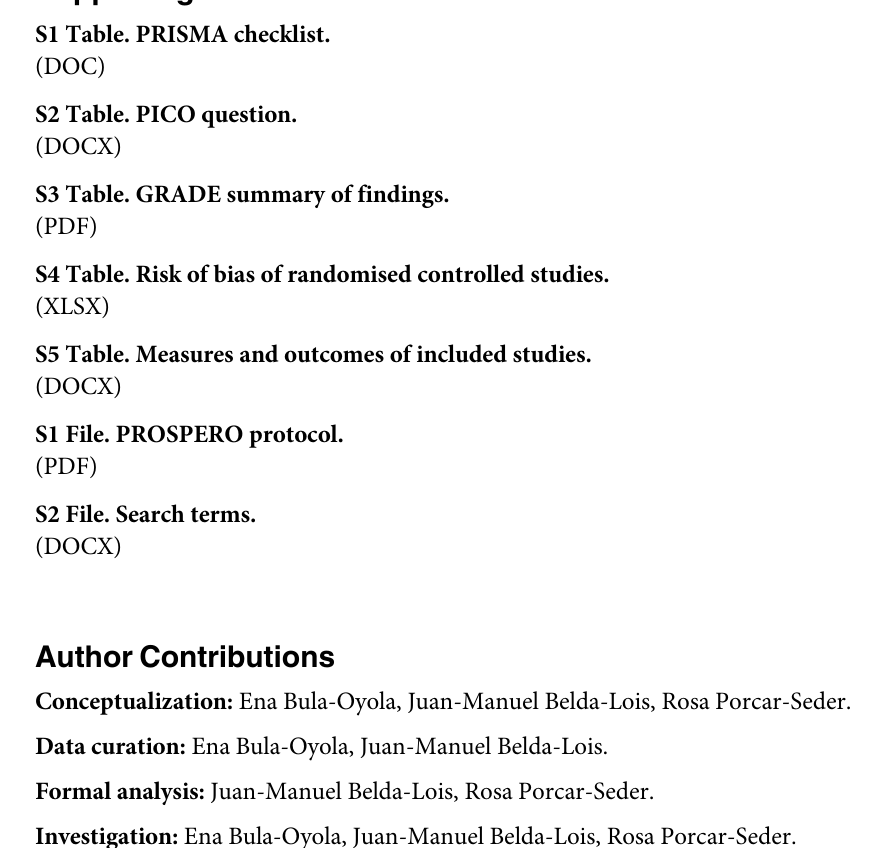
S1 Table. PRISMA checklist. S2 Table. PICO question. S3 Table. GRADE summary of findings. S4 Table. Risk of bias of randomised controlled studies. S5 Table. Measures and outcomes of included studies. S1 File. PROSPERO